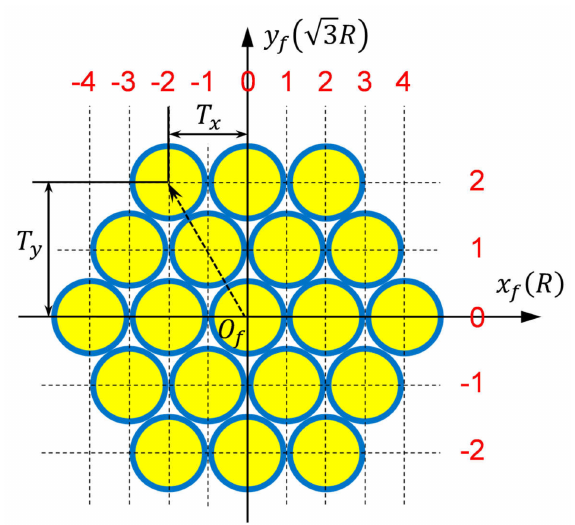
Figure 4. Fibers arranged in dense hexagonal shapes. By establishing the rectangular coordinate O f - x f y f , each fiber can be located. T x is an FOP translation period in the x f direction, and T y is an FOP translation period in the y f direction. T x = 2 R ; T y = 2